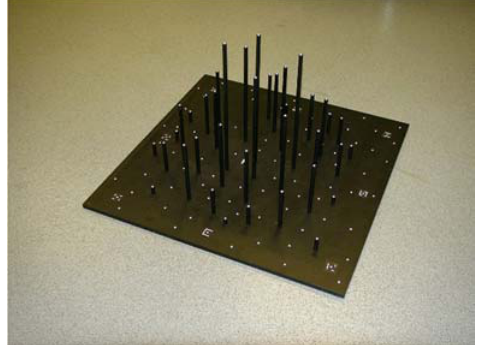
Figure 2. 3D test object illuminated by flash light, showing the distribution of retro-reflective targets and target codes.